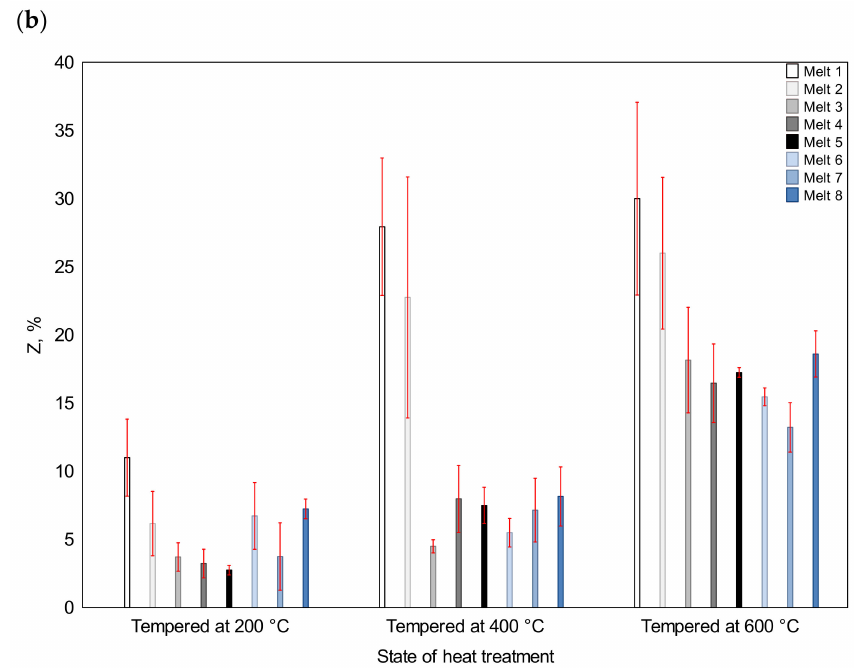
Figure 12. Percentage elongation ( a ) and the reduction of area after fracture ( b ) of the analyzed alloys after quenching and tempering at 200, 400 and 600 ◦